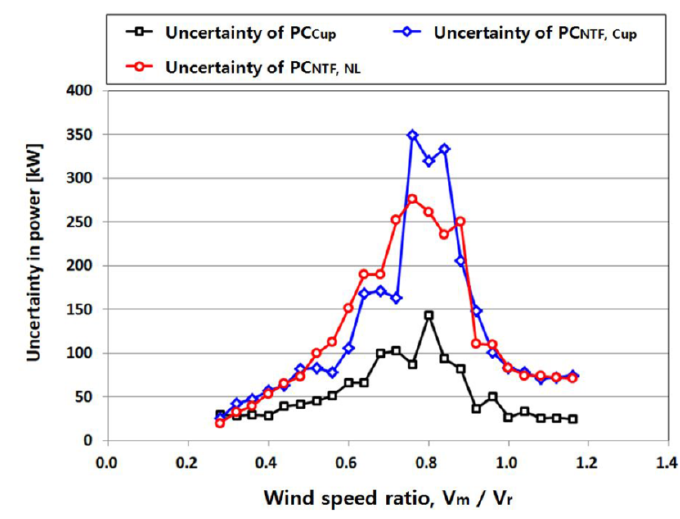
Figure 7. Comparison of combined standard uncertainties for power curves of wind turbine no. 15.